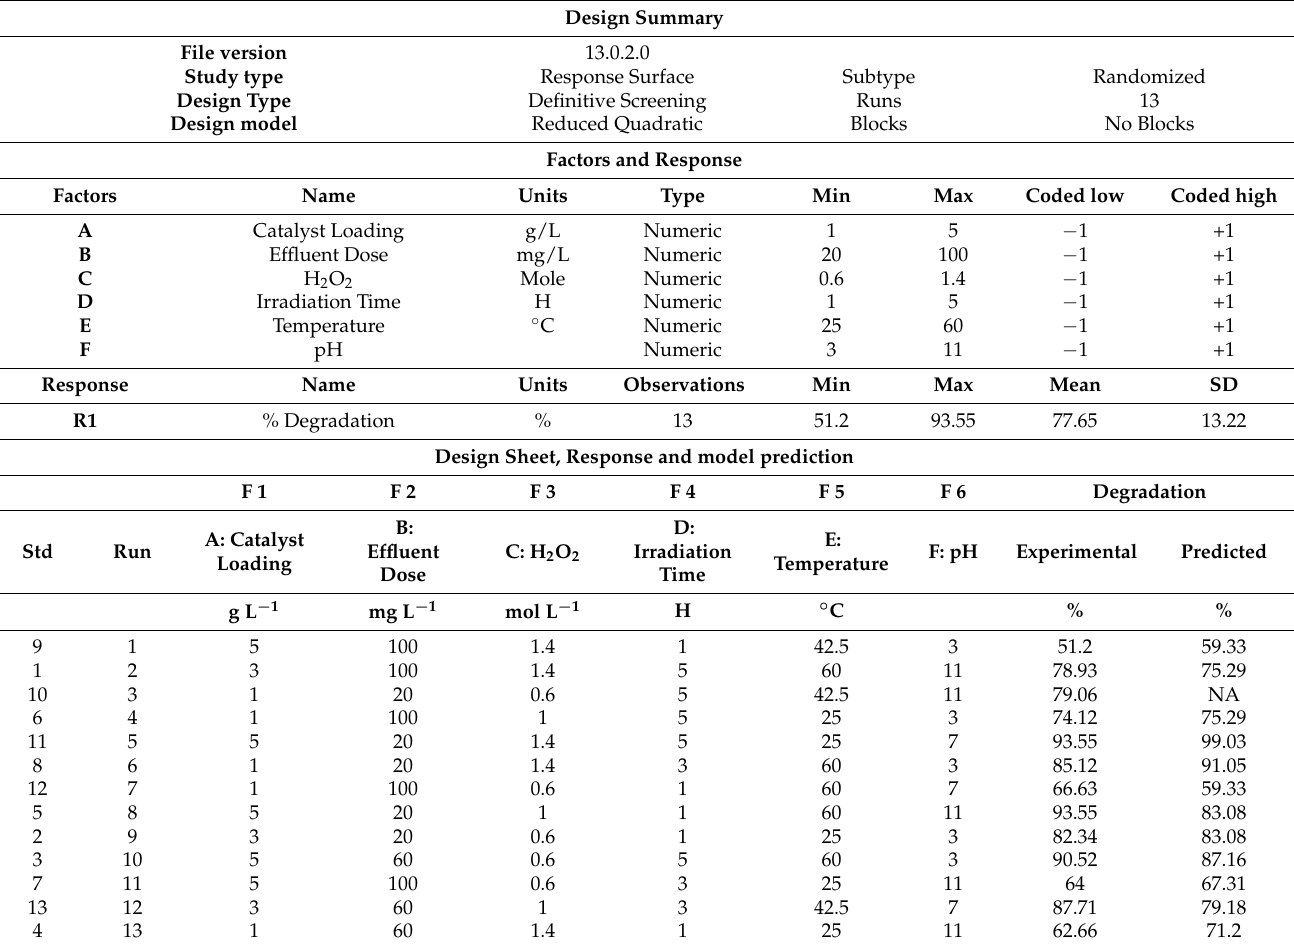
Table 1. Design summary, Factors and their Ranges with Response, and Design sheet with experi- mental data and their respective predicted